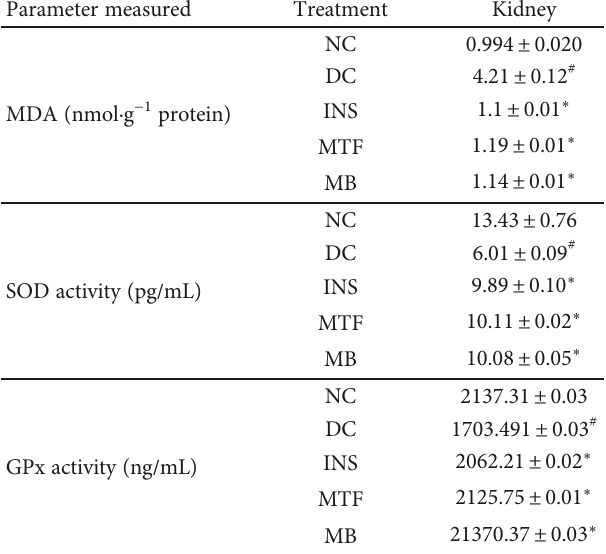
Table 5: E ff ects of MB on MDA concentrations and activities of SOD and GPx in kidney tissues of non-diabetic controls, diabetic controls, and diabetic rats treated with MB, metformin, and insulin. Values are expressed as mean ± SEM